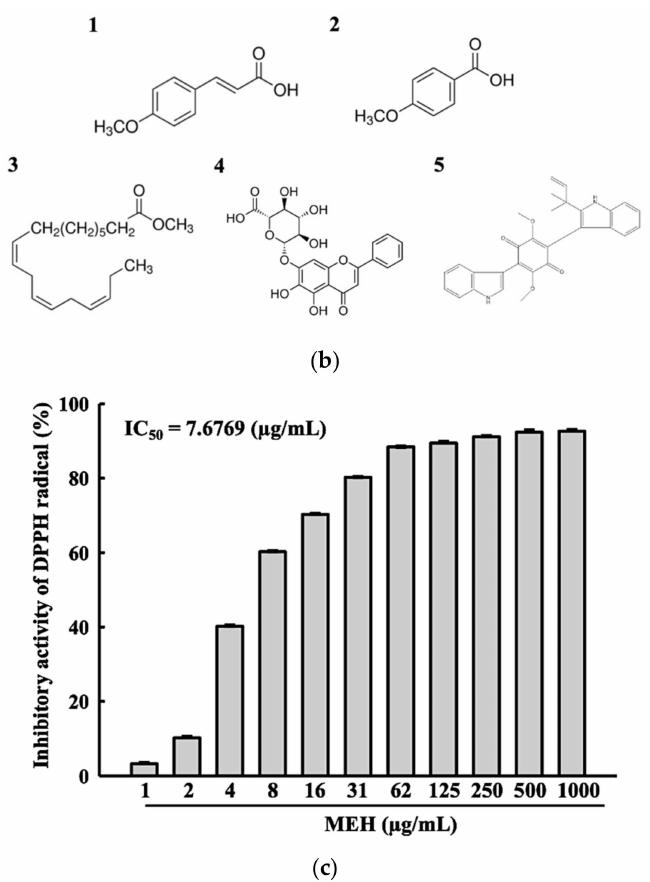
Figure 1. LC–MS analysis and DPPH scavenging activity of MEH. ( a ) Chromatogram of MEH. Five active components, ( 1 ) 4-methoxycinnamic acid, ( 2 ) 4-methoxybenzonic acid, ( 3 ) methyl linoleate, ( 4 ) baicalin, and ( 5 ) asterriquinone C-1, were detected in the chromatogram; ( b ) Chemical structure of the five bioactive components detected in Figure 1a; ( c ) DPPH radical scavenging activity of MEH. Three MEH dry samples were used to prepare the solution of MEH, and scavenging activity was measured in triplicate. Data are reported as the mean ± SD. Abbreviations: LC–MS/MS, liquid chromatography–tandem mass spectrometry; DPPH, 2,2-diphenyl-1-picrylhydrazyl; MEH, Methanol extract of Hygrophila erecta (Brum. F.)